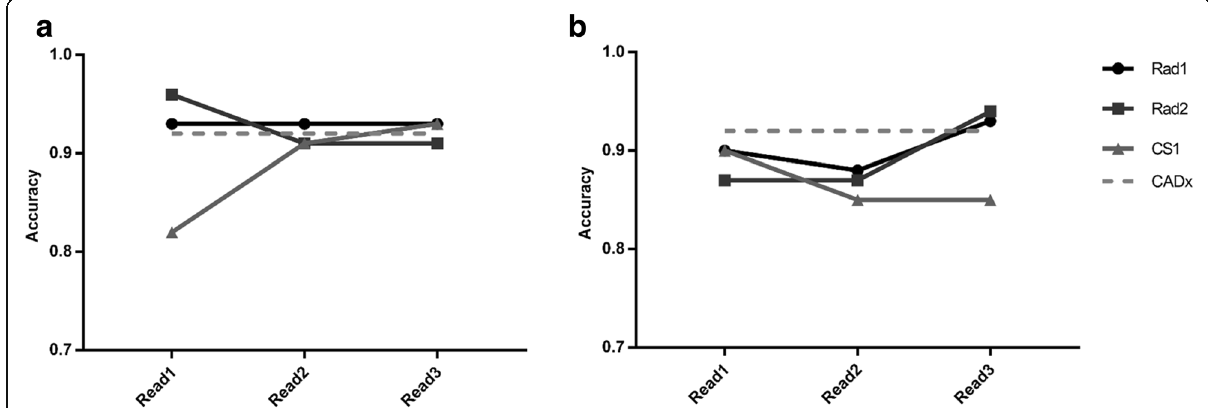
Fig. 3 Diagnostic accuracy figures for the the image reads. Diagnostic accuracy figures for the three image reads, for local data ( a ) and PPMI data ( b ). Standalone CADx performance is also shown, for